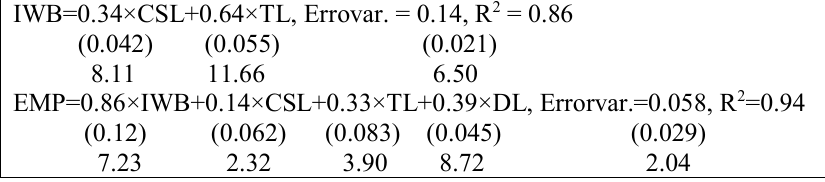
Fig. 3. Structural equation